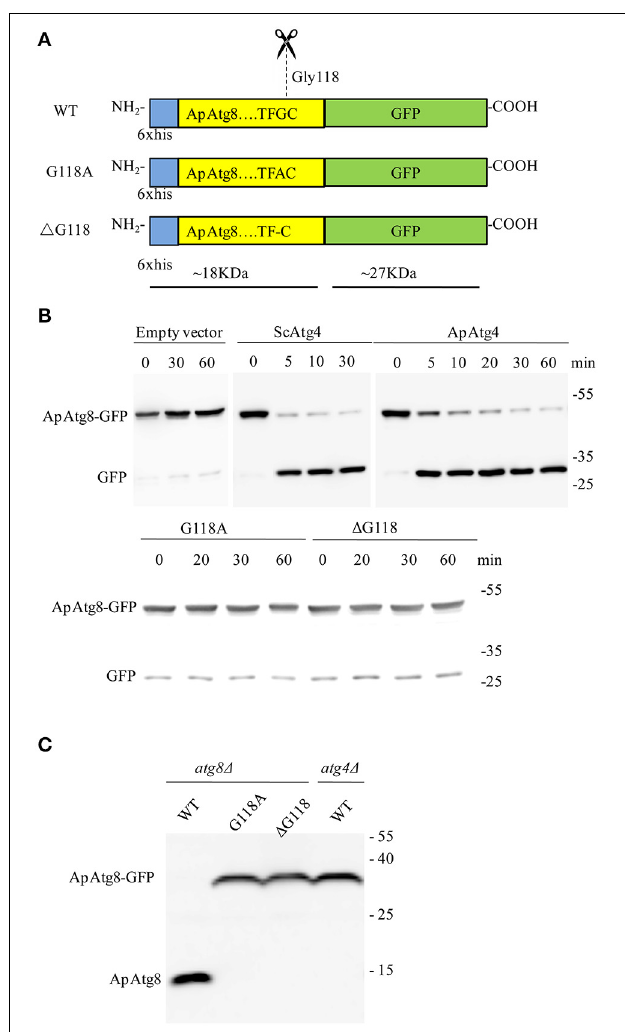
FIGURE 4 | ApAtg8 is processed by Atg4 at the C-terminal Gly-118 residue. (A) Diagrams of His-tagged ApAtg8-GFP (WT), ApAtg8 G118A -GFP (G118A) and ApAtg8 (cid:2) G118 -GFP ( (cid:2) G118). (B) Assay for cleavage of ApAtg8 by ApAtg4 in vitro . E. coli cells expressing WT (top panel), G118A and (cid:2) G118 (bottom panel) ApAtg8-GFP were homogenized and the total cell lysates were mixed with ApAtg4 lysate. Reactions were incubated at 30 ◦ C for the indicated times. Yeast Atg4 and empty vector were used as the positive and negative controls, respectively. The mixture was subjected to western blot using anti-GFP antibody. (C) Cleavage assay in yeast. WT, G118A, and (cid:2) G118 Atg8 were expressed in a yeast atg8 mutant (lanes 1, 2, and 3) or an atg4 mutant (lane4). Cells were harvested after nitrogen starvation for 4h. Total lysates were subjected to western blot using anti-His